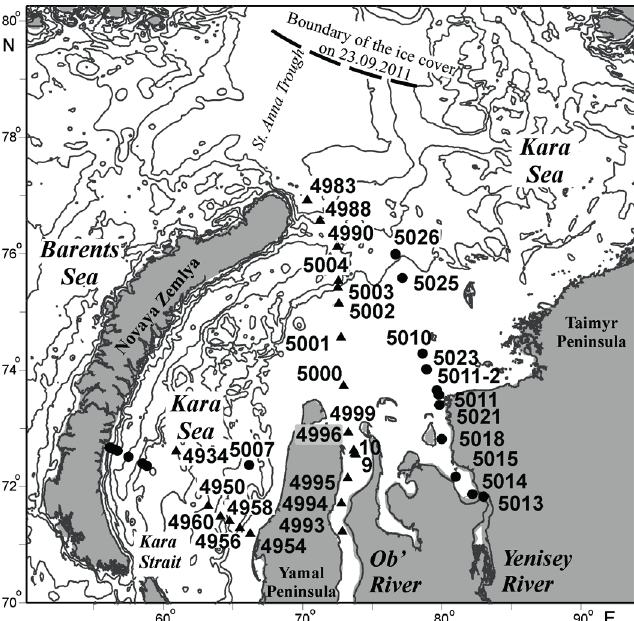
Fig. 1 The map of sampling sites during cruises of the RV Akademik Mstislav Keldysh in the Kara Sea, September–October 2007 (triangles) and 2011 (circles). Based on GEBCO